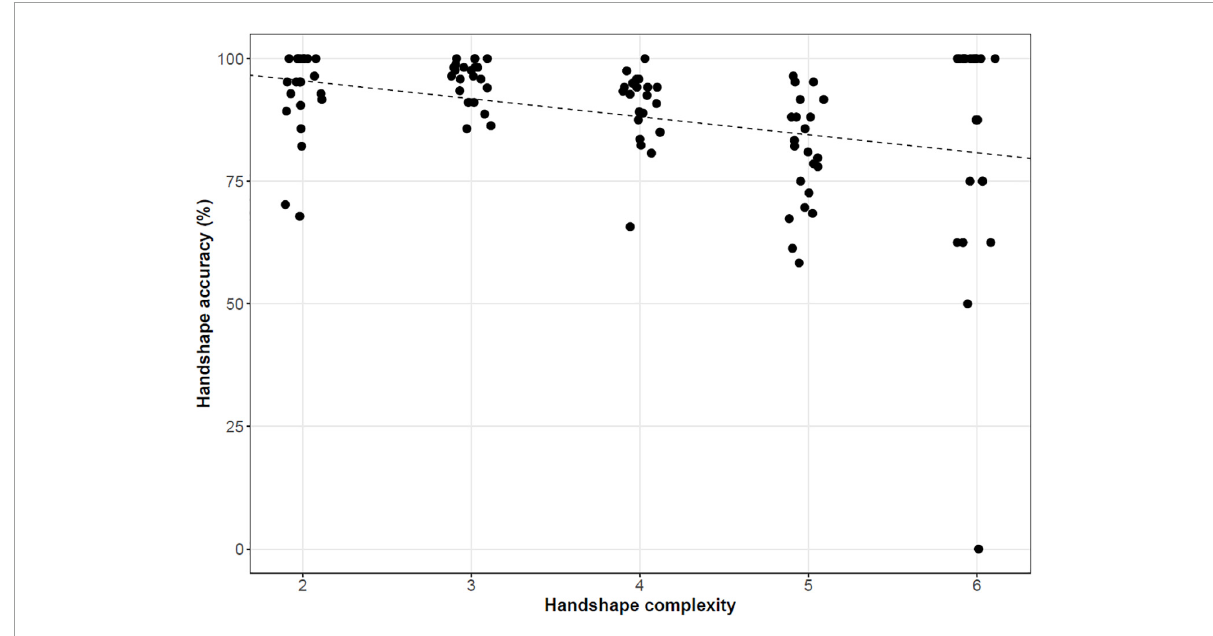
FIGURE8 Handshape parameter accuracy and its relationships to handshape complexity (intercept = 1.029, slope = 0.027, p = 0.001).